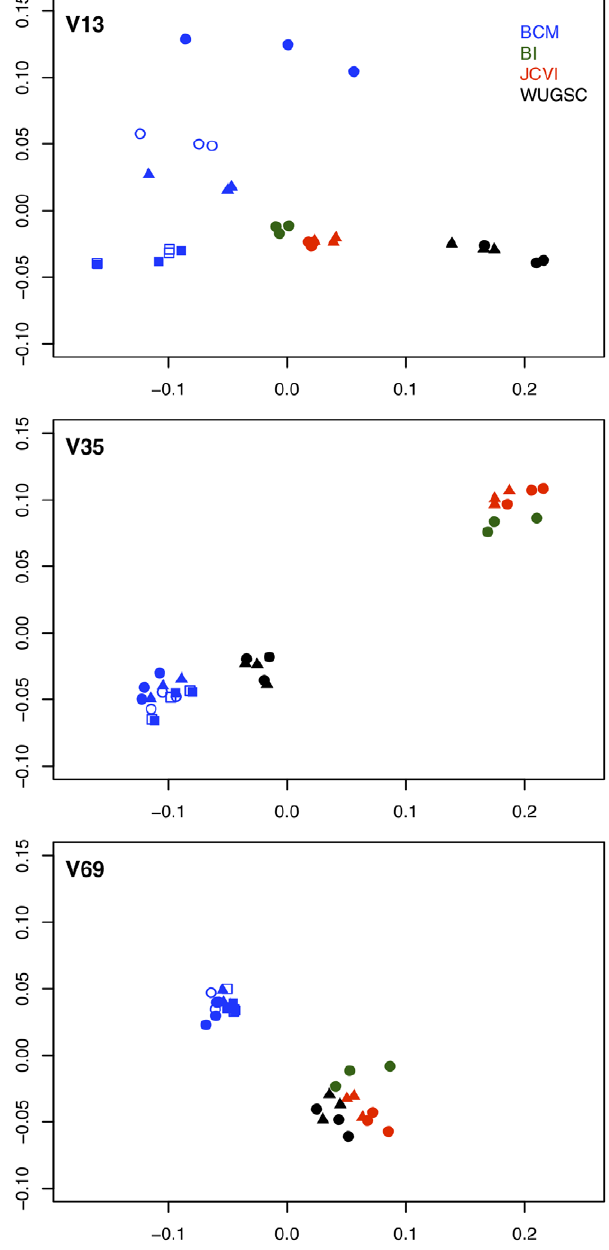
Figure 5. Non-metric multidimensional scaling (NMDS) plot generated using ThetaYC distances between mock community sequencing data after standardizing the number of sequences per sample. Points with the same color and shape originated from the same sequencing run.